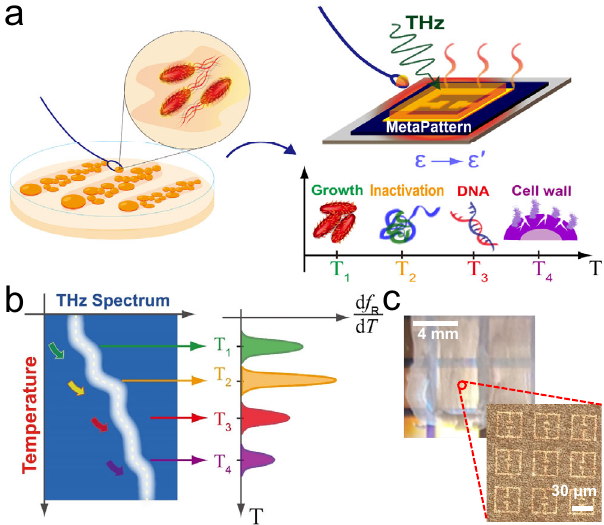
Fig. 1 Schematic of thermal curve analysis based on THz metamaterials. a Schematic of experiments. The microbial fi lms grown on a culture medium are transferred to THz metamaterials while samples are being heated. The microbes exhibit phase change with increasing temperature based on conditions for growth, inactivation, DNA denaturation, and cell wall destruction. b An abrupt change in the metamaterial resonance occurs in the transition between different growth and death phases, in which strong peaks appear in different thermal curves (DTCs). DTCs offer unique fi ngerprints for identifying different microbial species. c Photograph of metamaterial sensors coated with a microbial fi lm (30- µ m-thick E. coli fi